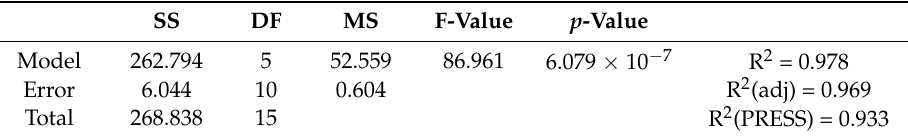
Table 2. Analysis of variance for FD model of PCL- g -GMA.